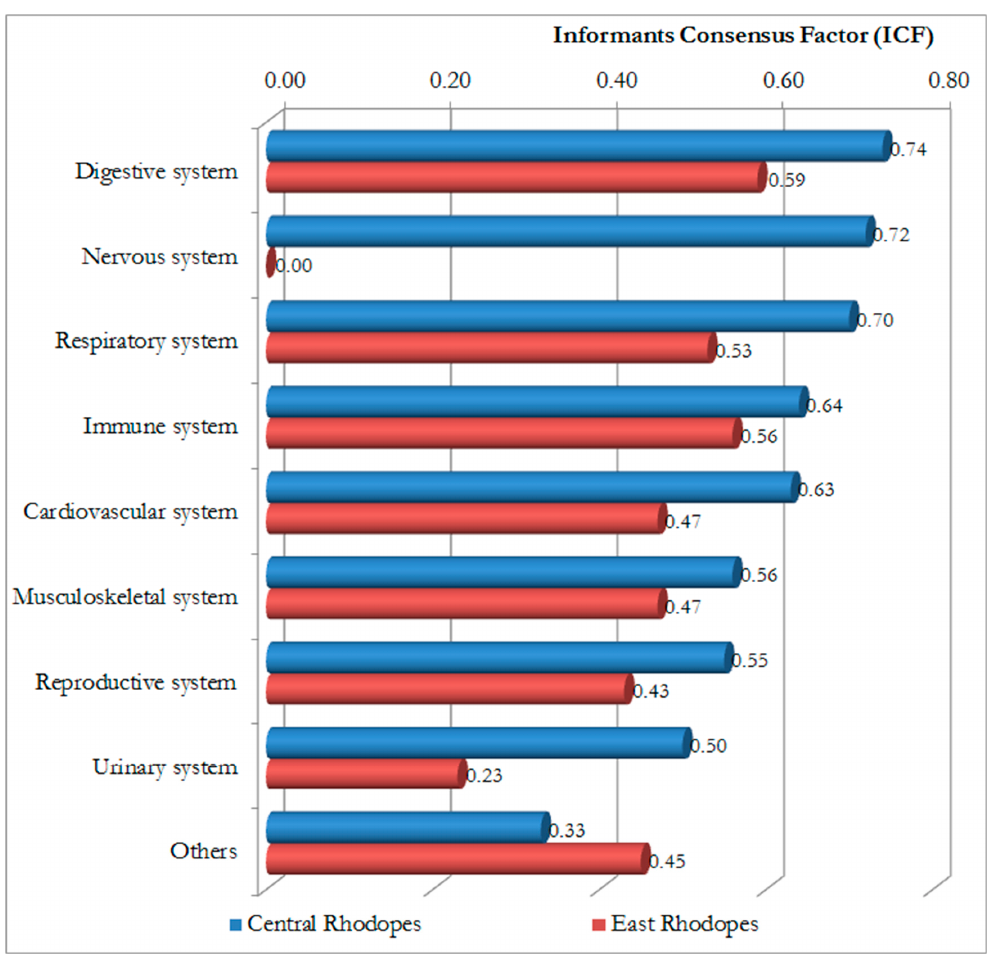
Figure 7. Comparison of di ff erent disease categories by ICF values .